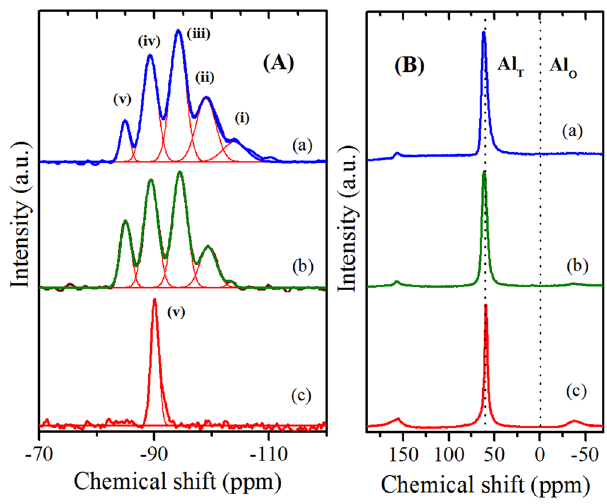
Figure 5. 29Si MAS NMR ( A ) and 27Al MAS NMR ( B ) spectra of: (a) ZH-Y; (b) ZH-X; (c) ZH-A.